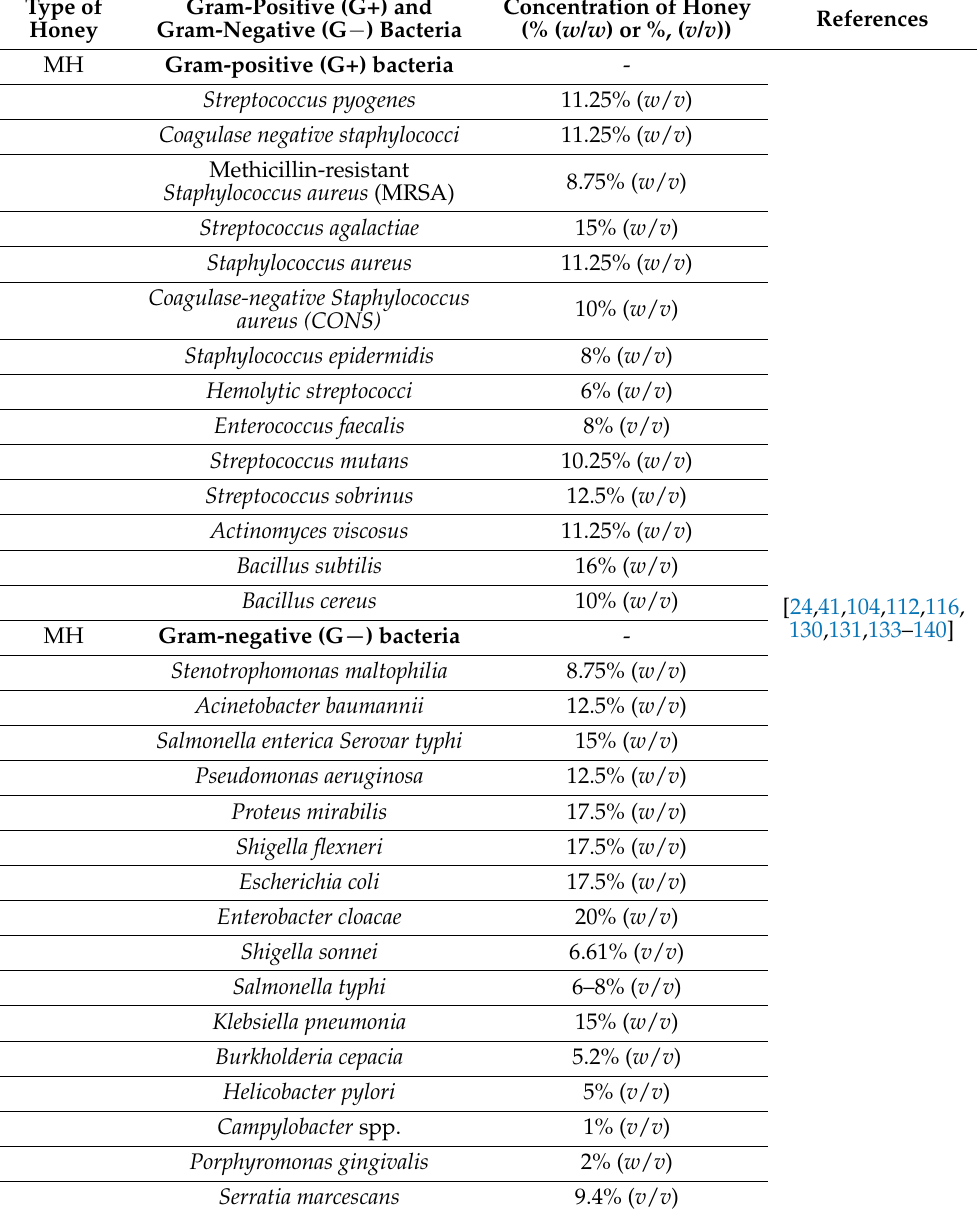
Table 4. List of micro-organisms that have been found to be sensitive to MH, TH, KH, and SH. Type of